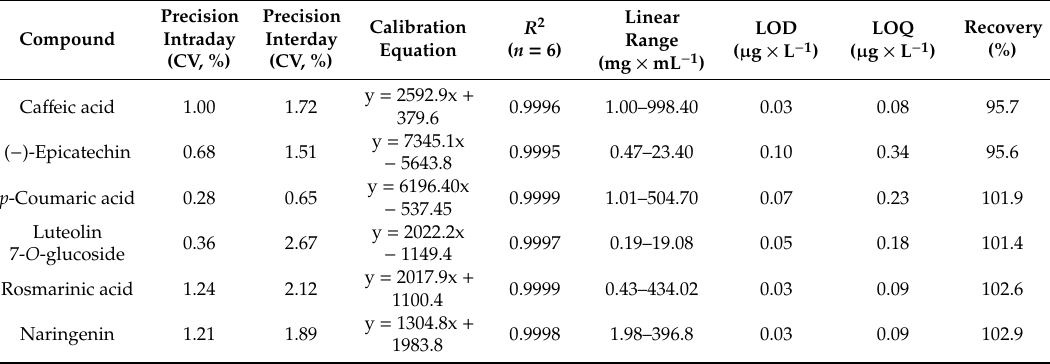
Table 1. Validation parameters of the HPLC-DAD analysis ( n =